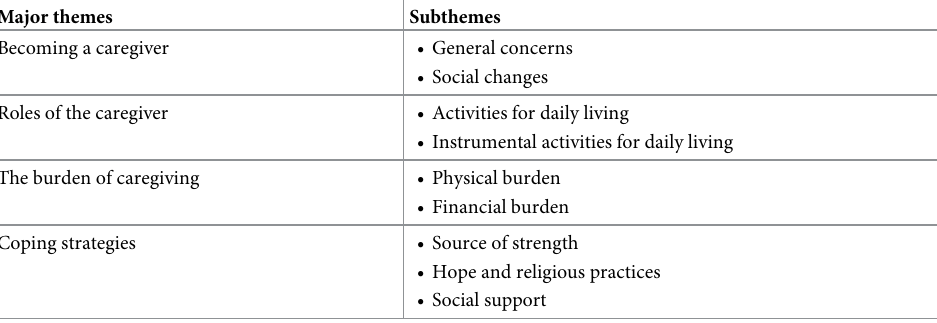
Table 1. Themes and sub-themes generated from the